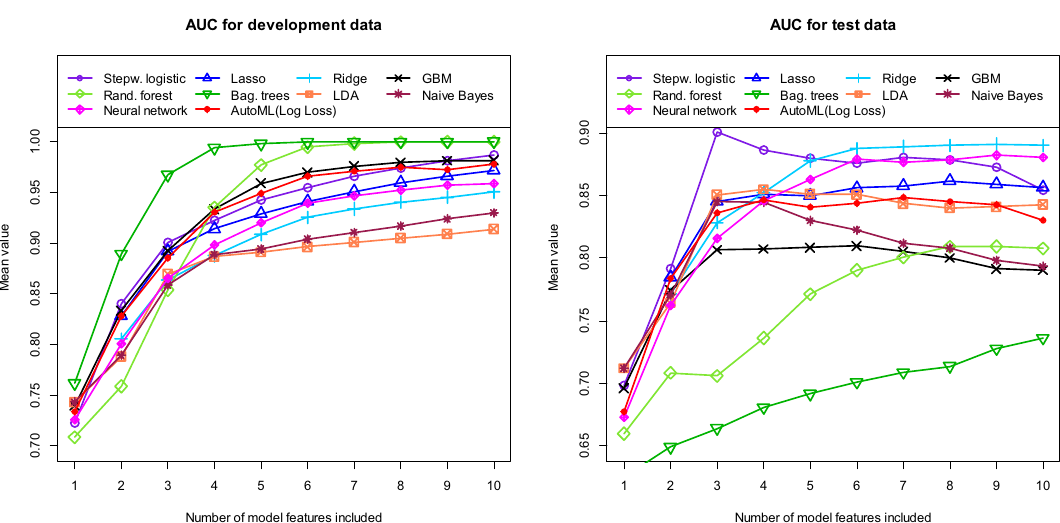
Figure 5. Area Under the Curve (AUC) for AutoML (red lines), neural network (pink lines) and conventional machine learning models (other lines). Left figure: training data. Right figure: independent test data. All values calculated as means of 100 repetitions (100